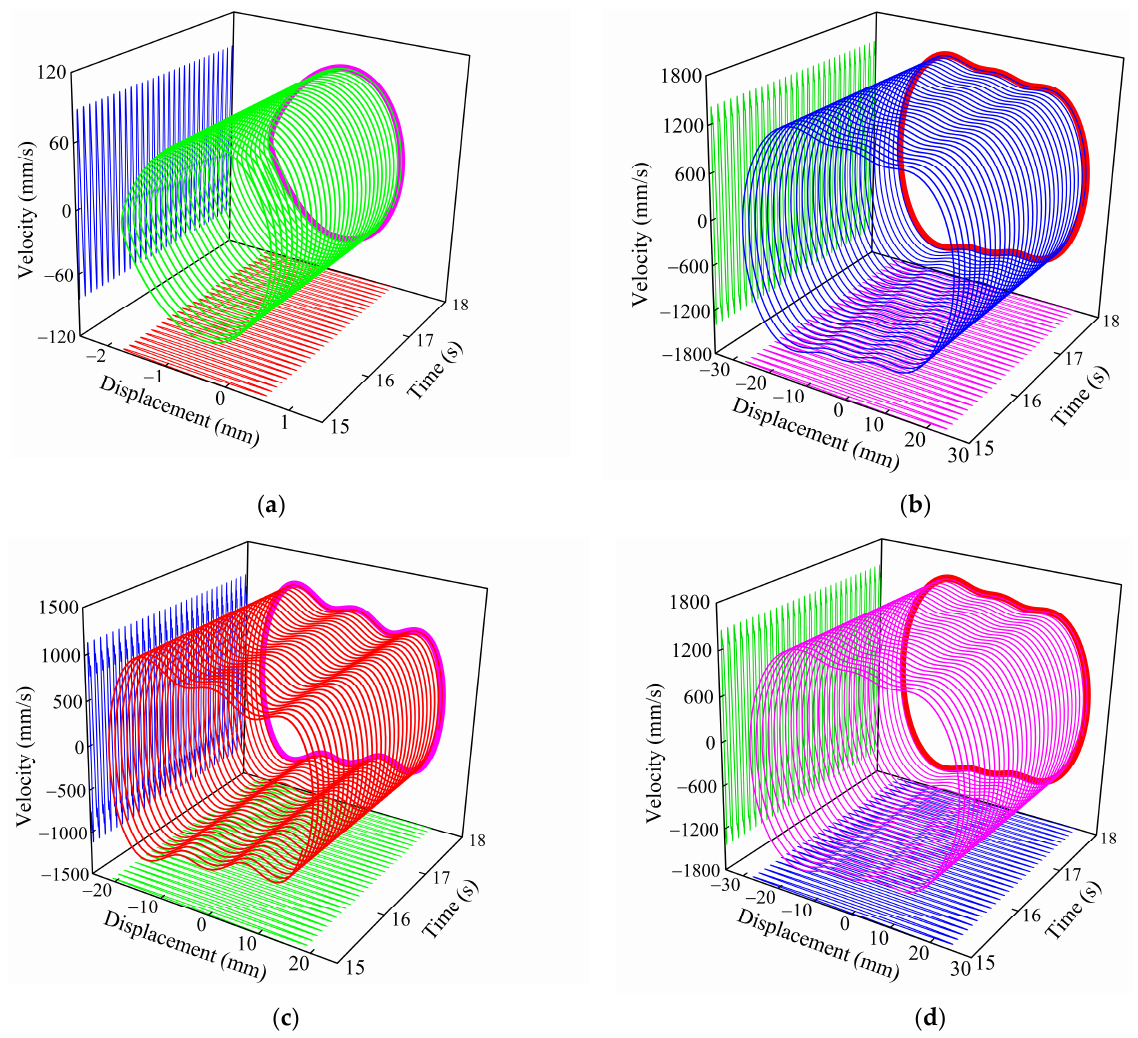
Figure 9. 3D time domain simulation diagram of the system under different M e , and A : ( a ) M e = 4 g A = 10 m/s 2 ; ( b ) M e = 8 g A = 10 m/s 2 ; ( c ) M e = 4 g A = 14 m/s 2 ; ( d ) M e = 8 g A = 14 m/s 2